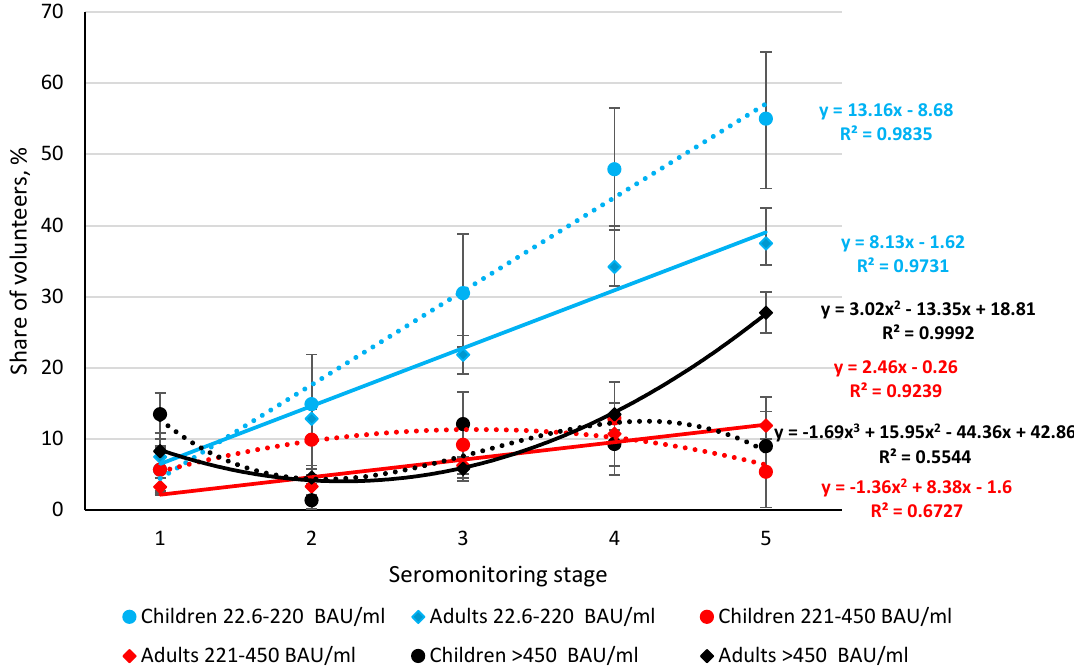
Figure 4. Distribution dynamics of anti-RBD antibody levels among children and adults, by seromonitoring stage. Colored lines are Ab distribution trends in children (dashed) and adults (solid). Trend equations and determination coefficients, in their corresponding colors, are shown on the right side of the graph next to their curves. Black vertical lines are 95% confidence intervals. Antibody values are given in BAU/ml (Table S3).